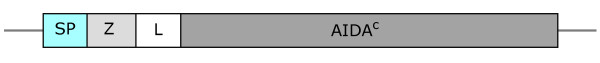
Surface expression vector. Components are shown to approximate and relative sizes. The construct contains the native signal sequence for AIDA (SP), the protein Z passenger (Z), a linker region (L) and the C-terminal β-barrel domain (AIDAc) of AIDA.